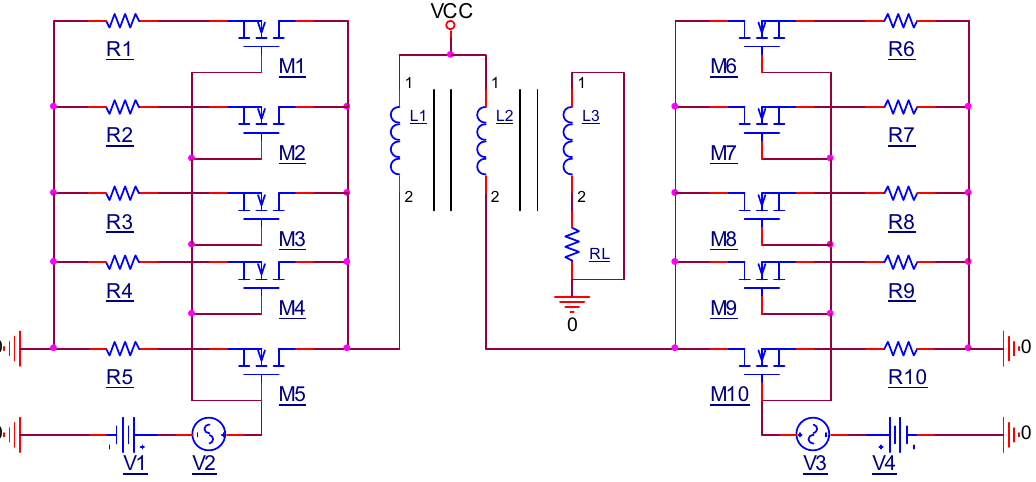
Figure 1. Linear amplification parallel output circuit with five linear amplification modules (LAMs).